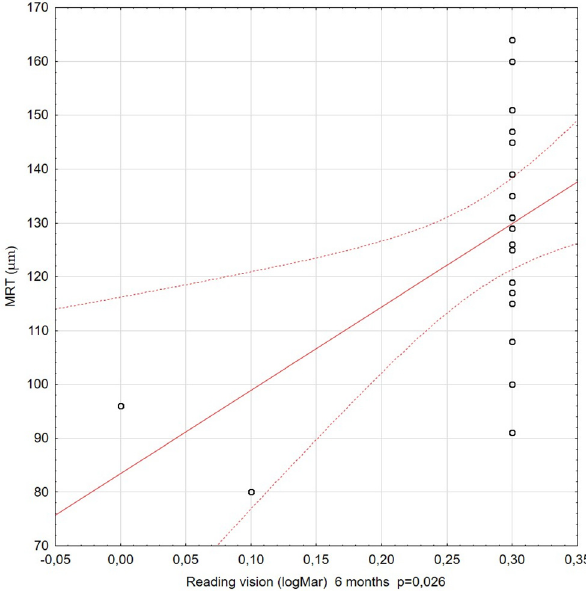
Figure 9. Correlation between reading vision (RV) (at 6 months) and minimal retinal thickness (MRT). A statistically significant correlation was observed: better RV correlated with higher MRT values.